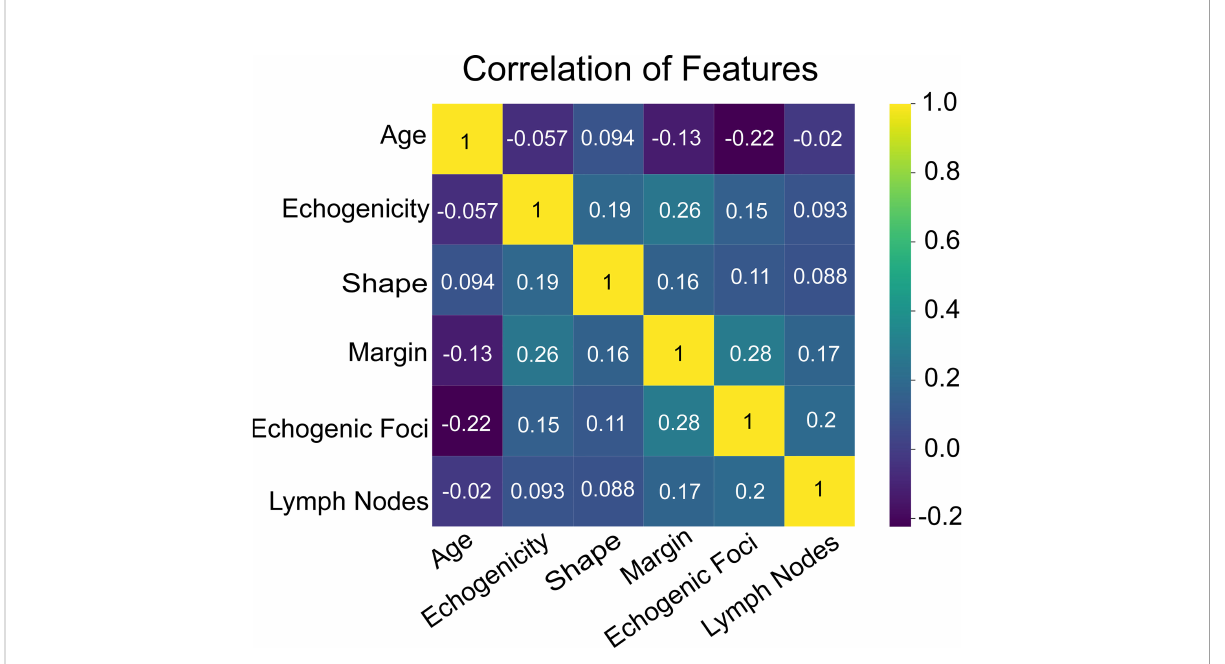
FIGURE 6 The heat map of correlation of the selected features, including age, echogenicity, shape, margin, echogenic foci, and lymph